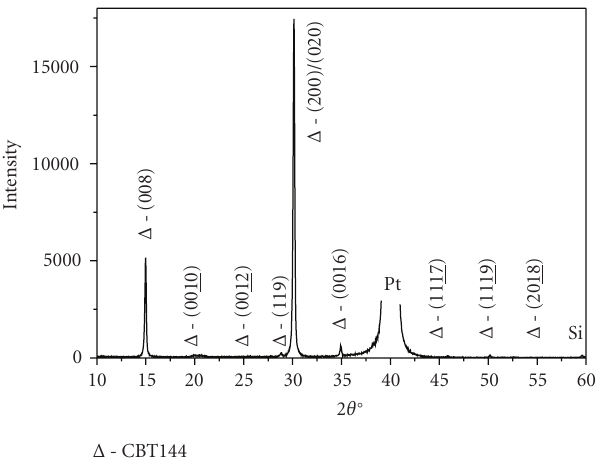
Figure 1: X-ray di ff raction for CBTi144 thin film deposited on (100) Pt/Ti/SiO 2 /Si substrate at 700 ◦ C for 2